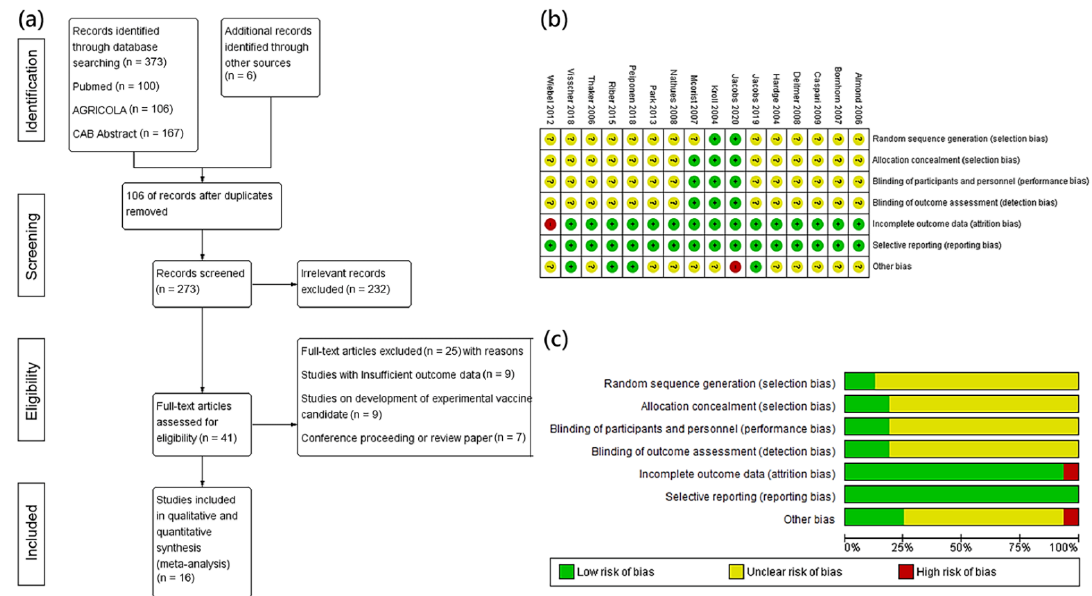
Figure 1. ( a ) Flowchart presenting article selection of the studies through the systematic review process and assessment of the risk of bias in this meta-analysis. ( b ) Summary of the risk of bias based on the Cochrane guideline. The symbols “+”, “ − ”, and “?” indicate low, high, and unclear risk of bias, respectively. ( c ) Risk of bias graph for each item expressed as percentages across the selected studies. Table 1. Primary reasons for the exclusion of 25 of 41 reviewed studies on swine vaccination against L. intracellularis from the meta-analysis.